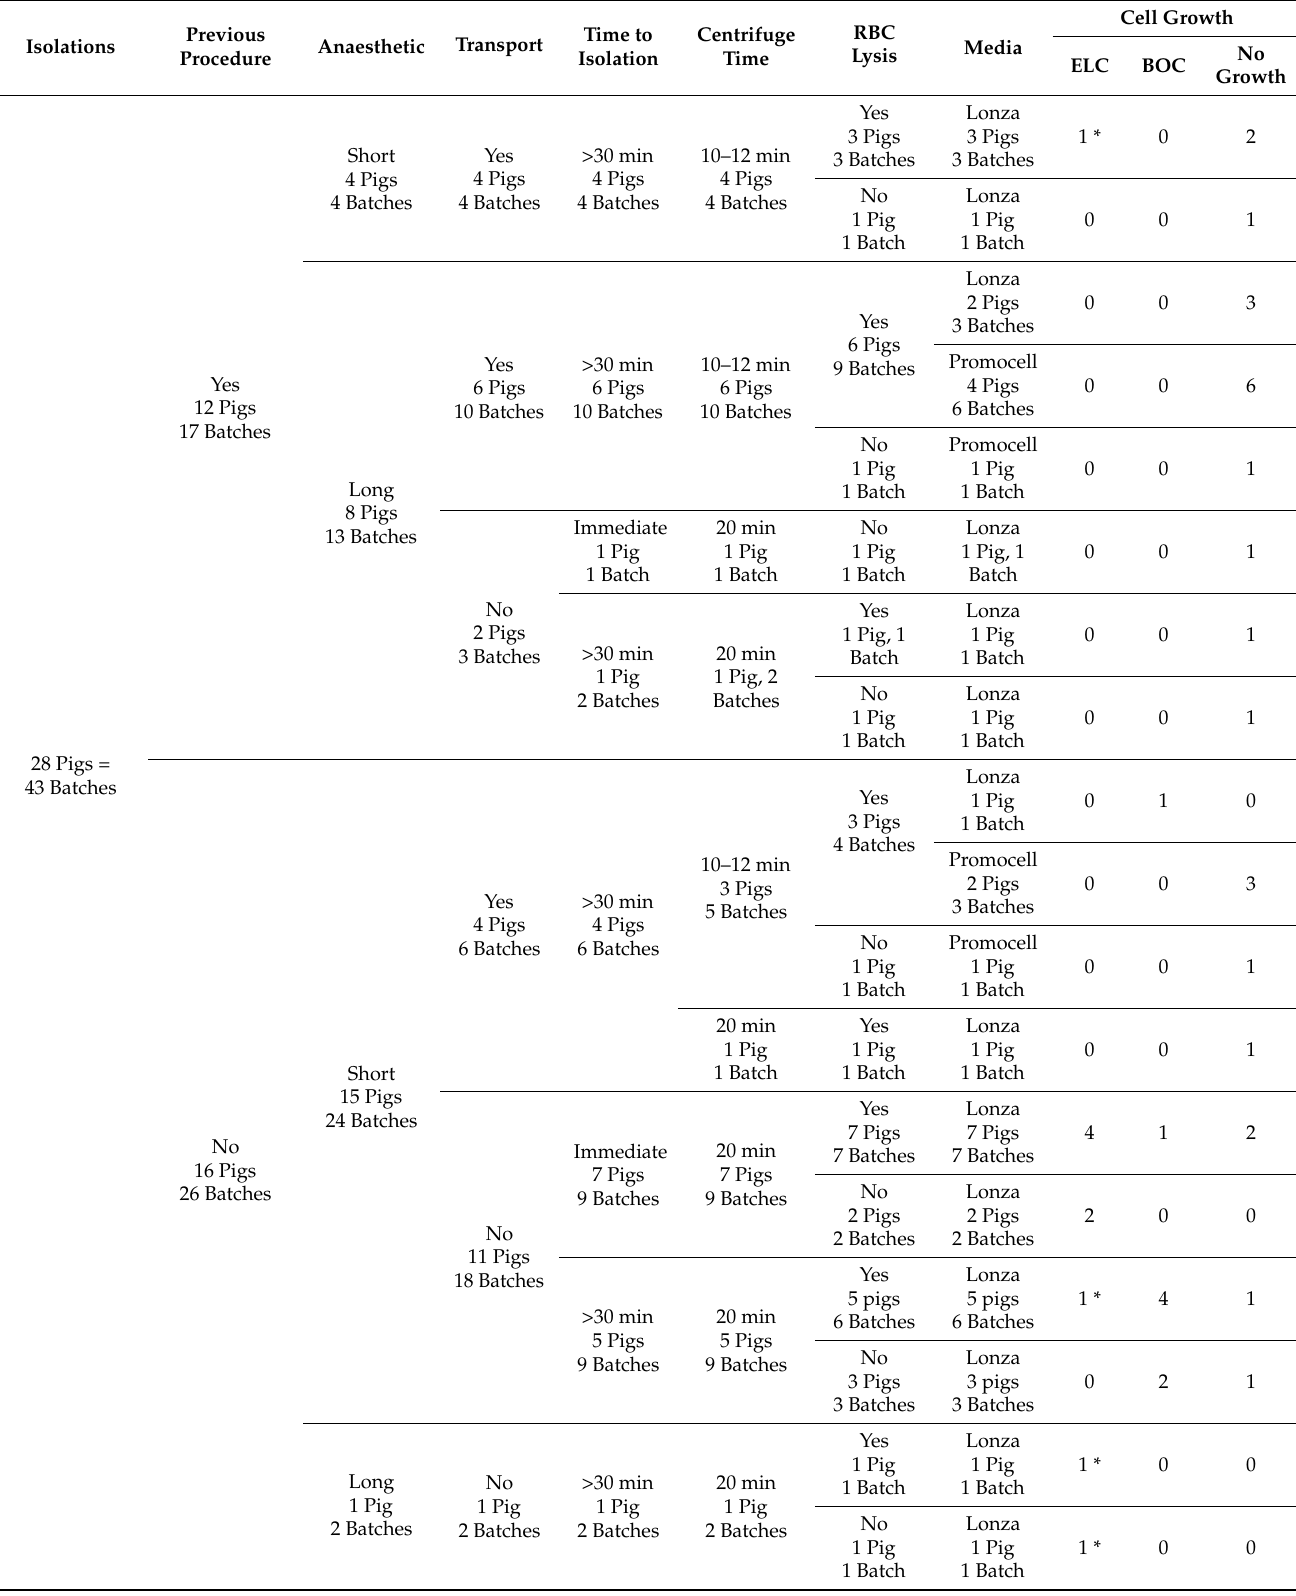
Table 1. Conditions used for isolating ELC from blood taken under surgical